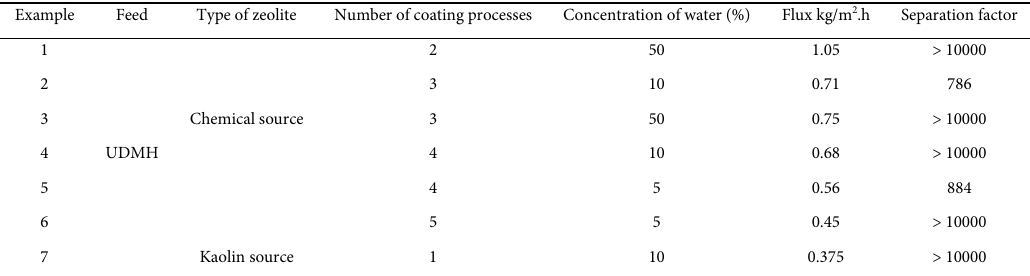
Table 2. Flux and separation factor of the membranes